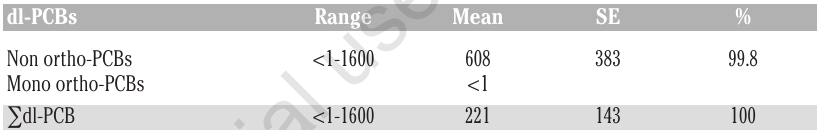
Table 3. Toxic equivalency of dioxin-like polychlorinated biphenyls in Yamuna River water (pg World Health Organization-toxic equivalent quantities L -1 ).